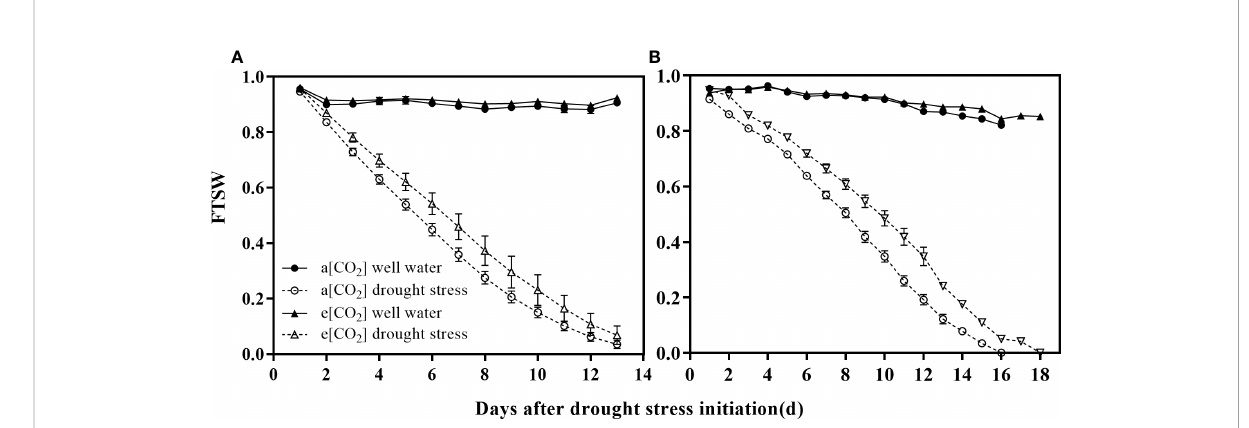
FIGURE 2 Trends of the fraction of transpirable soil water (FTSW) over time for well-watered and drought-stressed pots in which (A) wheat and (B) maize were grown under ambient (400 ppm, a [CO 2 ]) and elevated (800 ppm, e [CO 2 ]) atmospheric CO 2 concentrations during progressive soil drying. Error bars indicate the standard error of the means (S.E.) (n =